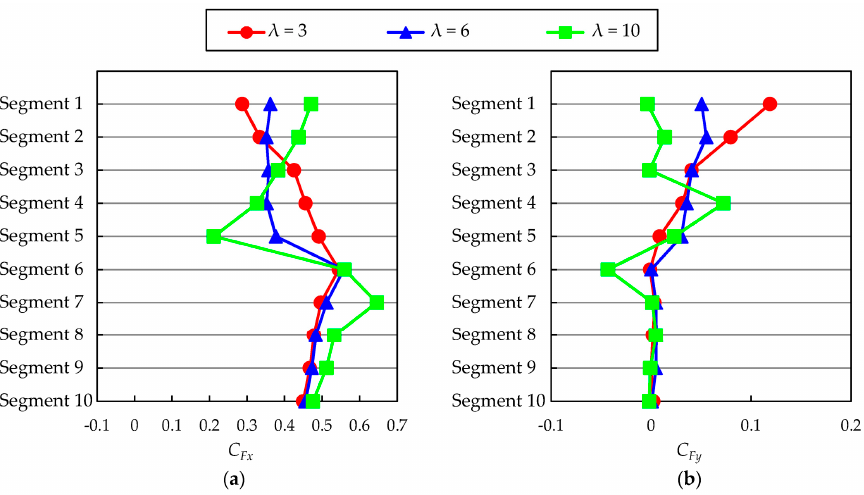
Figure 13. Vertical distributions of the mean drag and mean lift coefficients of each tower segment. ( a ) Mean drag coefficient; and ( b ) mean lift coefficient.